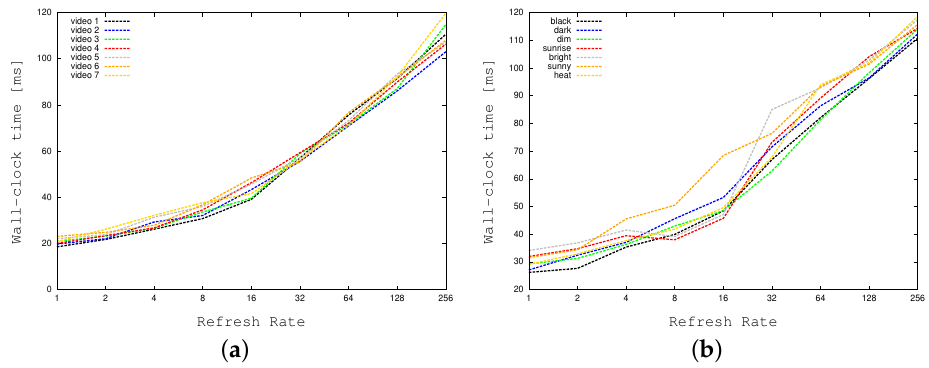
Figure 18. Computation times of our implementation (with no multi-threading) as a function of the refresh rate on the embedded system. Standard ( a ), and extreme (black, dark, dim, sunrise, bright, sunny, heat) weather conditions ( b